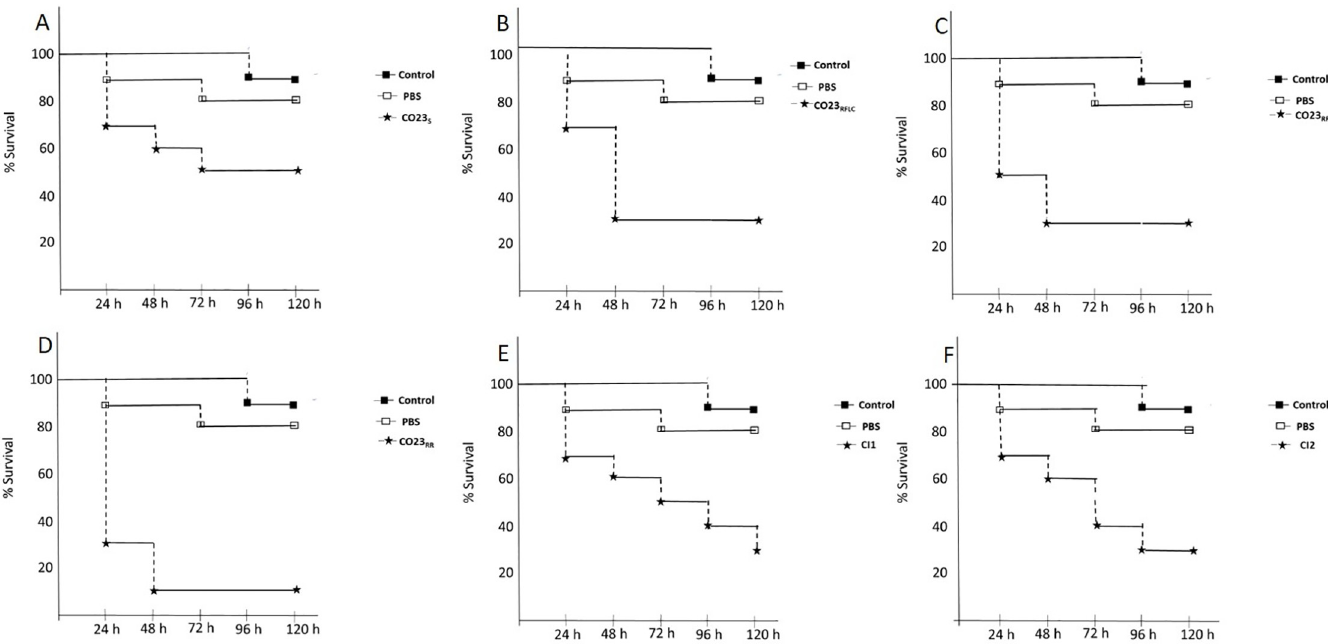
Fig 1. Infection in G . mellonella by sensitive and resistant C . albicans strains. Comparison of sensitive and resistant strains of C . albicans virulence in G . mellonella infected with 2x10 3 fungal cells/larvae and incubated at 37˚C up to 5 days. (A) CO23 S ,(B) CO23R FLC , (C) CO23 RFK , (D) CO23 RR , (E) CI1 (F) CI2. Results are expressed as % survival. Experiments with samples untreated or injected with PBS are reported as controls. Each experiment was repeated three times.